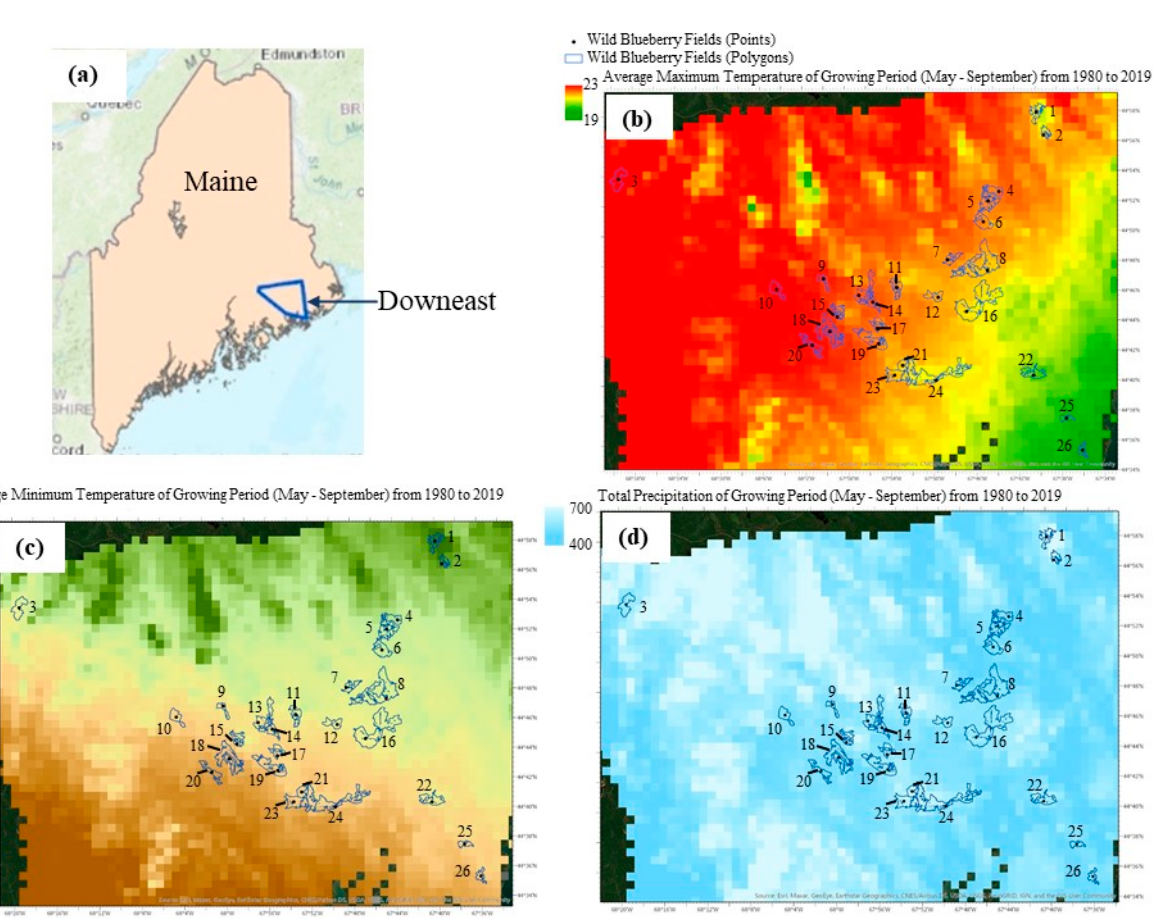
Figure 1. Location and average climatic conditions of the study sites. ( a ) A map of Maine showing the study location in Downeast, Maine by the dark blue boundary (a large part of the Washington Co. and a small part of the Hancock Co.). ( b ) Average maximum temperature (Tmax, °C). ( c ) Average minimum temperature (Tmin, °C). ( d ) Total rainfall (Ptotal, mm) during the growing season (May to September) averaged over 40 years (1980–2019) in Downeast, Maine where 26 wild blueberry fields (area of each field ≥ 1 km 2 ) are shown as the 26 black points inside the field polygons (shown by light blue borders) and labeled with numbers 1 to 26.